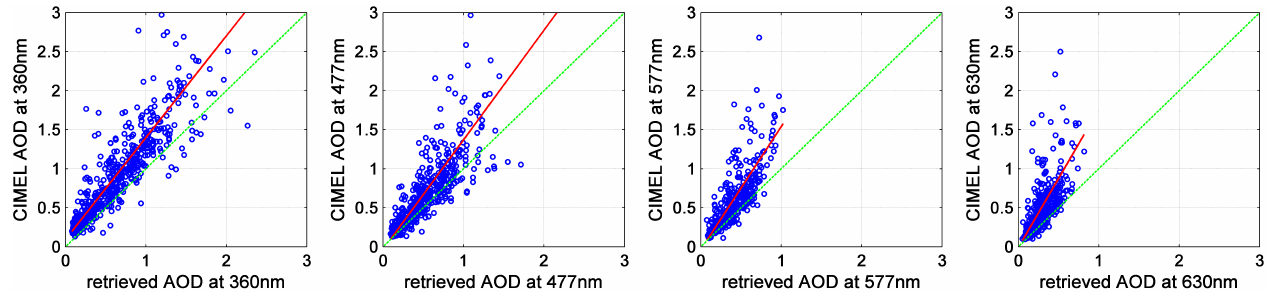
Fig. 15. Scatter plots of the total AODs at 360, 477, 577, and 630nm retrieved using the uncorrected O 4 DSCDs from the MAXDOAS measurements in Beijing versus the values from a co-located CIMEL instrument. Also shown are the linear regressions (red lines). Fit parameters and statistics are found in Table